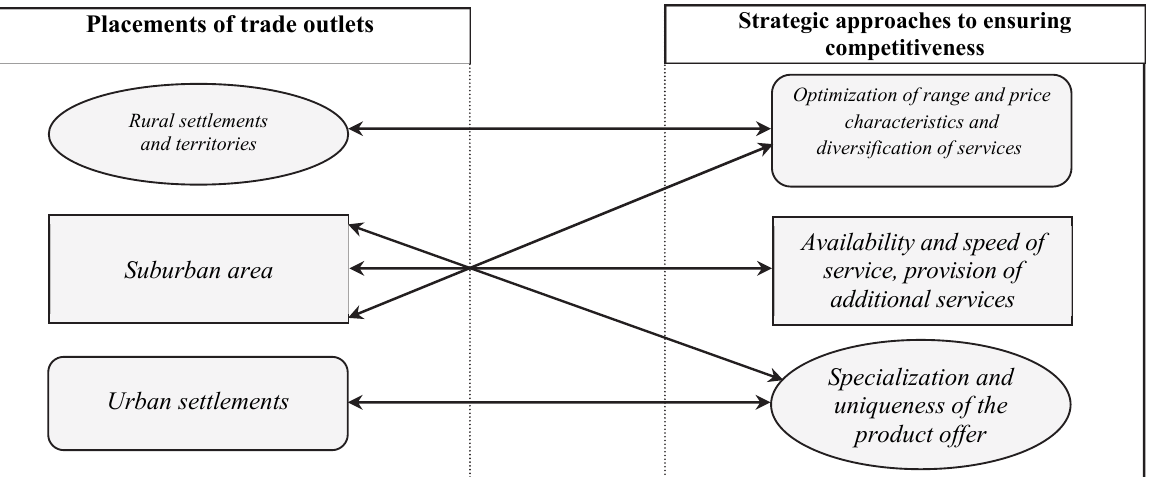
Fig. 5. Matrix of the choice of strategic decisions on ensuring competitiveness depending on the location of socially-oriented